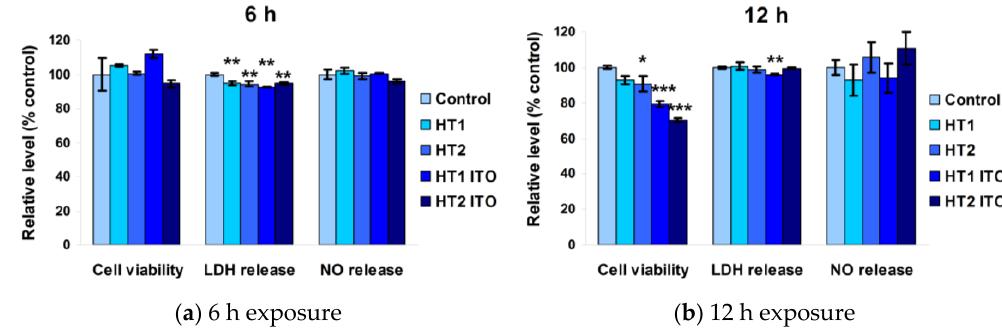
Figure 6. Biocompatibility of PES samples as shown by cell viability, lactate dehydrogenase (LDH), and nitric oxide (NO) release assays after 6 h ( a ) and 12 h ( b ) exposure on normal skin fibroblasts. Results are expressed as the mean ± standard deviation (SD) ( n = 3) and represented relative to the untreated PES sample (control). * p < 0.05, ** p < 0.01 and *** p < 0.001 compared to control.